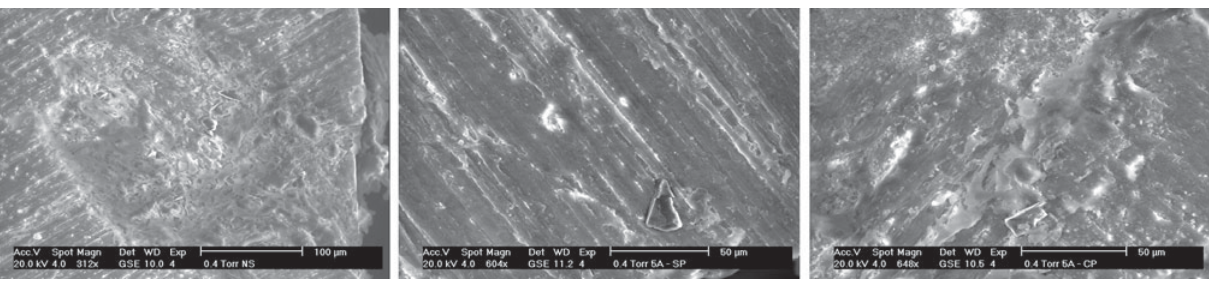
Figure 4 . SEM micrograph of the external surfaces of the samples for (a) NS; (b) 5YWP; (c) 5YBP.